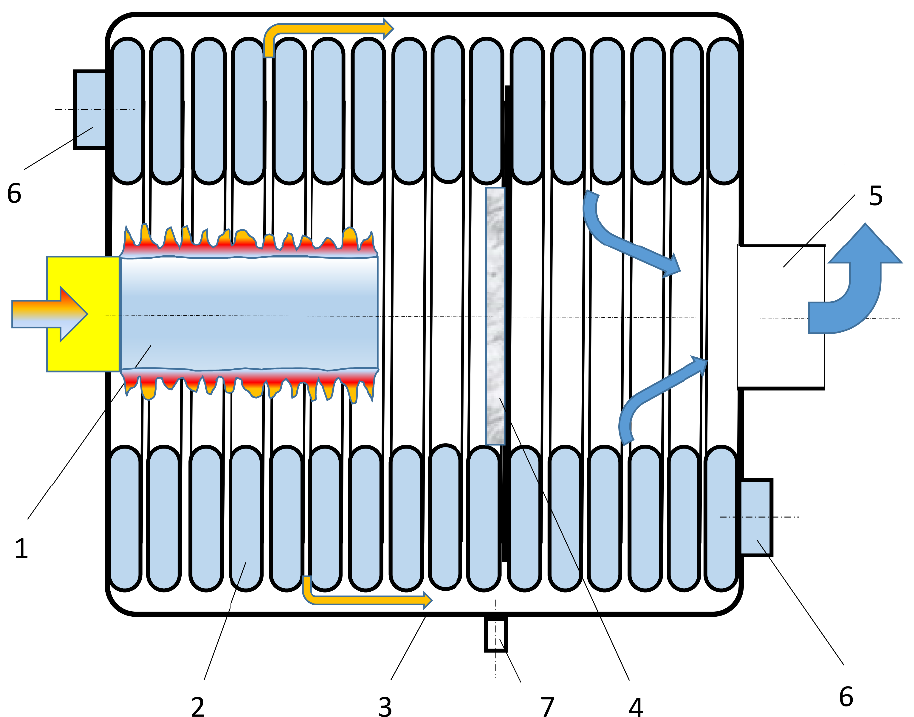
Figure 2. Boiler with flattened pipes.